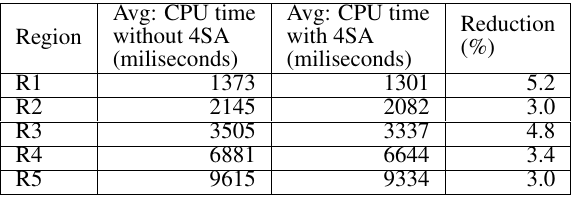
Table 3. Impact of 4SA on CPU execution time